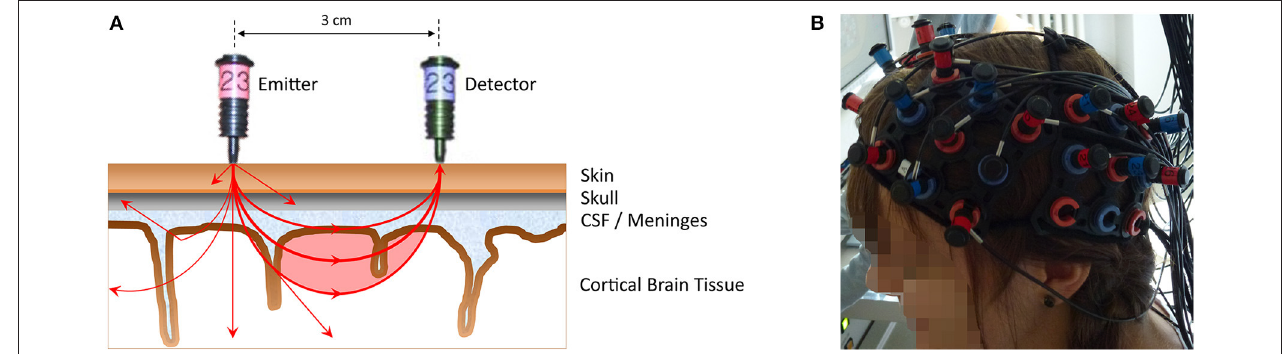
FIGURE 1 | (A) A simplified illustration of an emitter-detector optode pair (i.e., one measurement channel) representing the principles of NIRS measurement (distance 3cm, Hitachi ETG-4000). Near-infrared light from the emitter (red optode) penetrates the scalp to pass through different biological tissues (e.g., skin, skull,